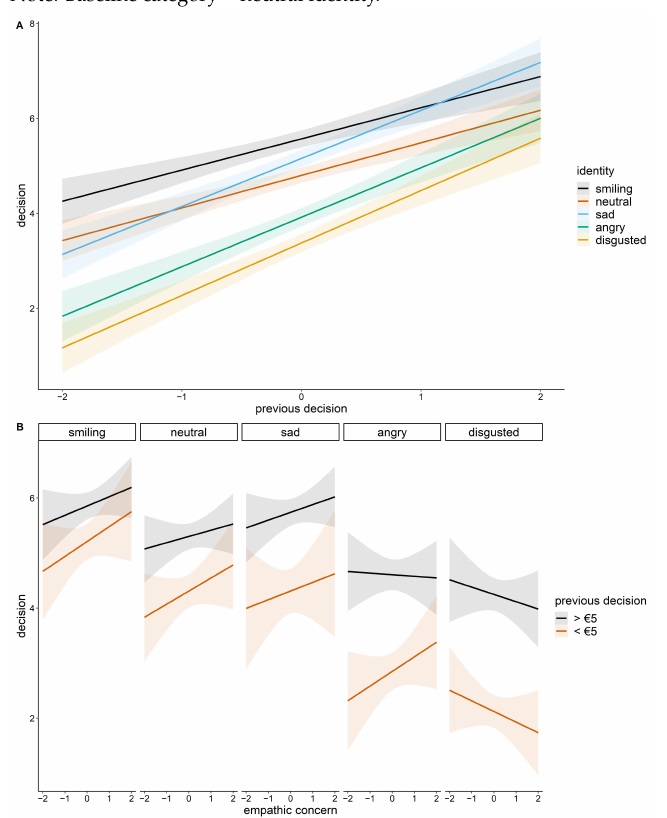
Figure 2. Interactions between fixed effects predictors. ( A ) Two-way interaction between the decision in the preceding trial (previous decision) and recipient identity; ( B ) Three-way interaction